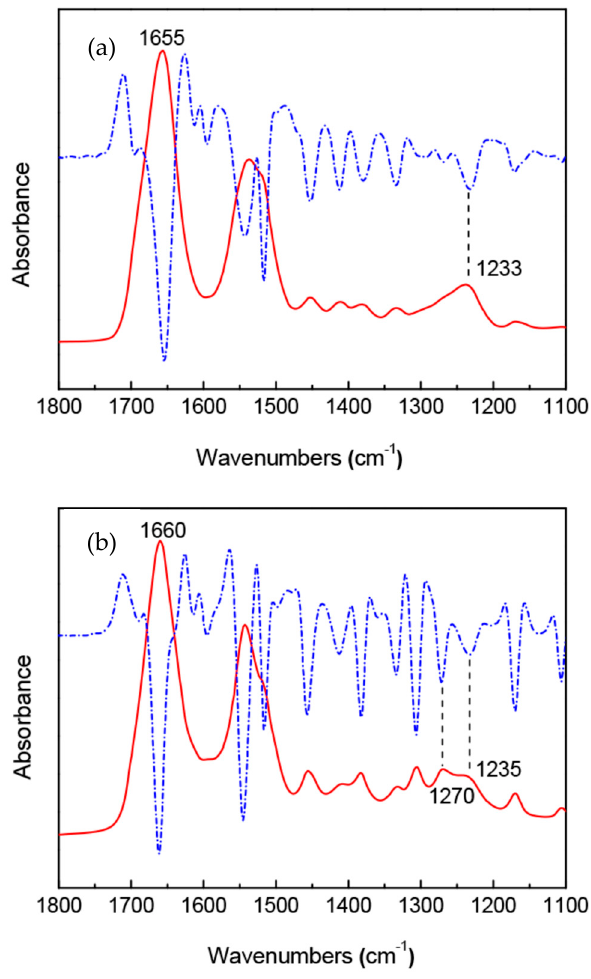
Figure 13. FTIR (solid line) and second derivative (dashed line) spectra of ( a ) B. mori silk fibroin membrane as cast with silk I structure and ( b ) A. pernyi silk fibroin membrane as cast [36,37]. Reprinted with permission from ref. 36.